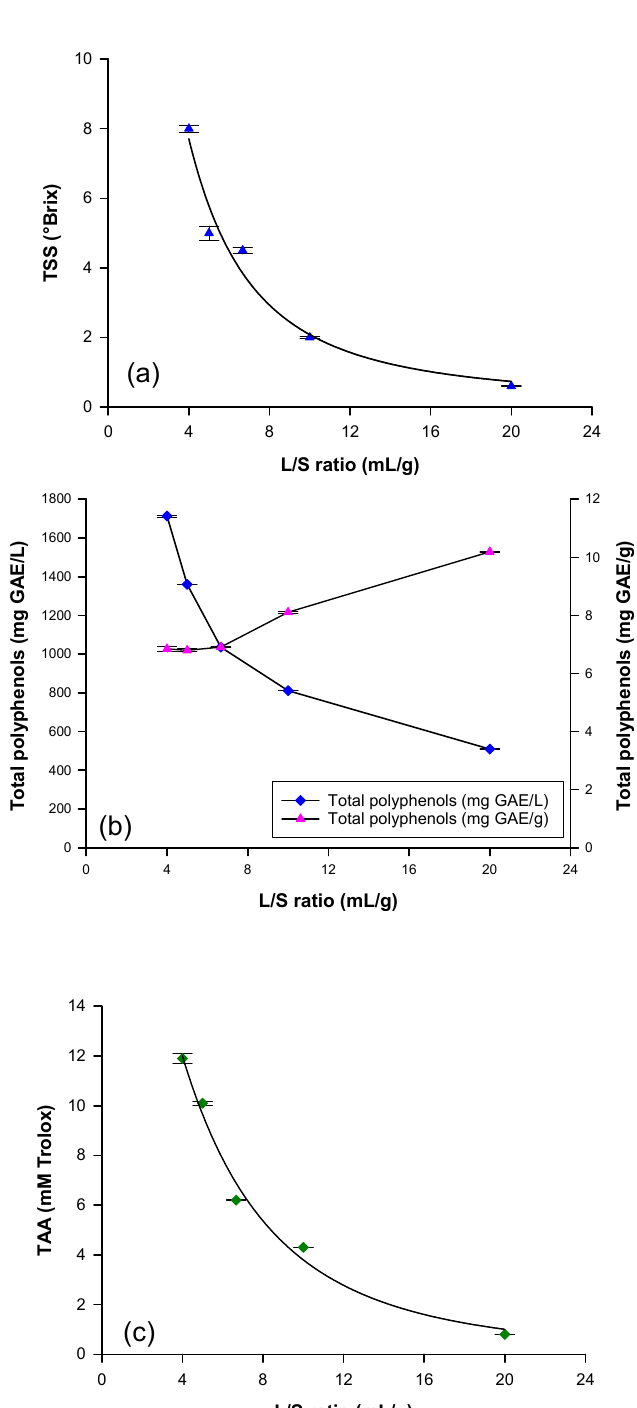
Figure 3. Effect of L/S ratio on ( a ) total soluble solid (TSS), ( b ) total polyphenol, and ( c ) total antioxidant activity (TAA) yields.